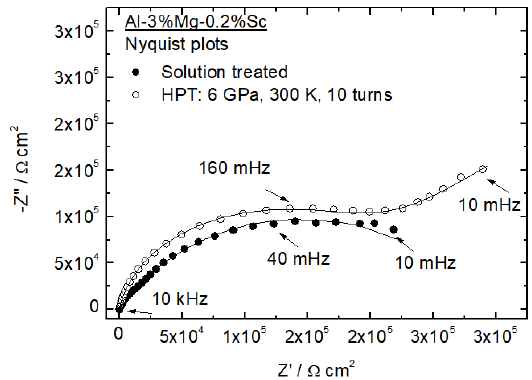
Figure 5. Nyquist diagrams of the solution treated and the HPT- processed alloys in 3.5 wt./v.% NaCl solution after 1 h stabilization at the OCP Table 2. Fitting results of electrochemical parameters for solution treated and HPT processed